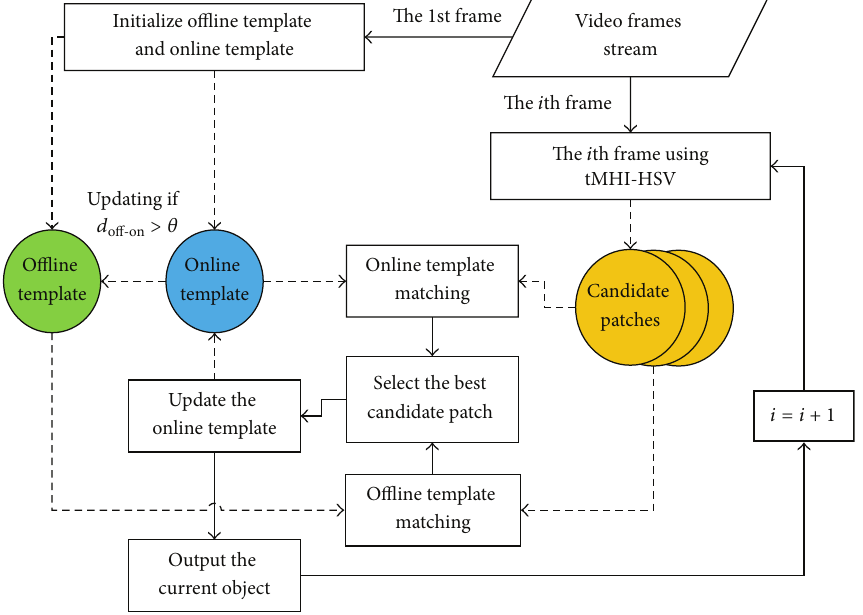
Figure 2: Block diagram of the proposed